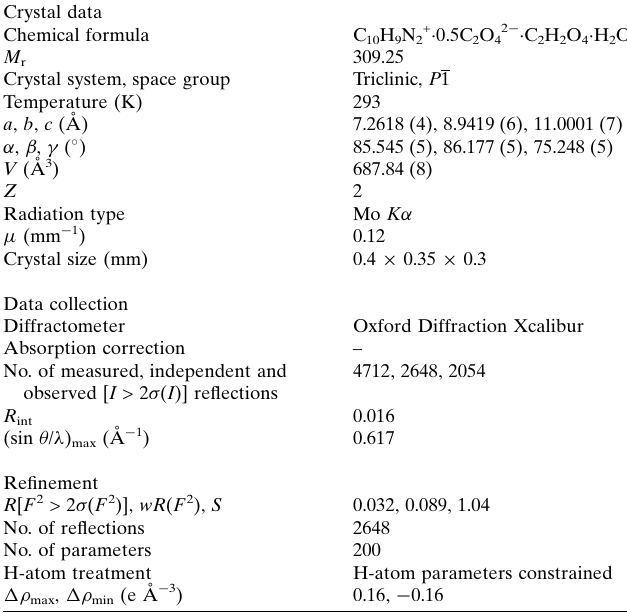
Table 2 Experimental details. Crystal data Chemical formula